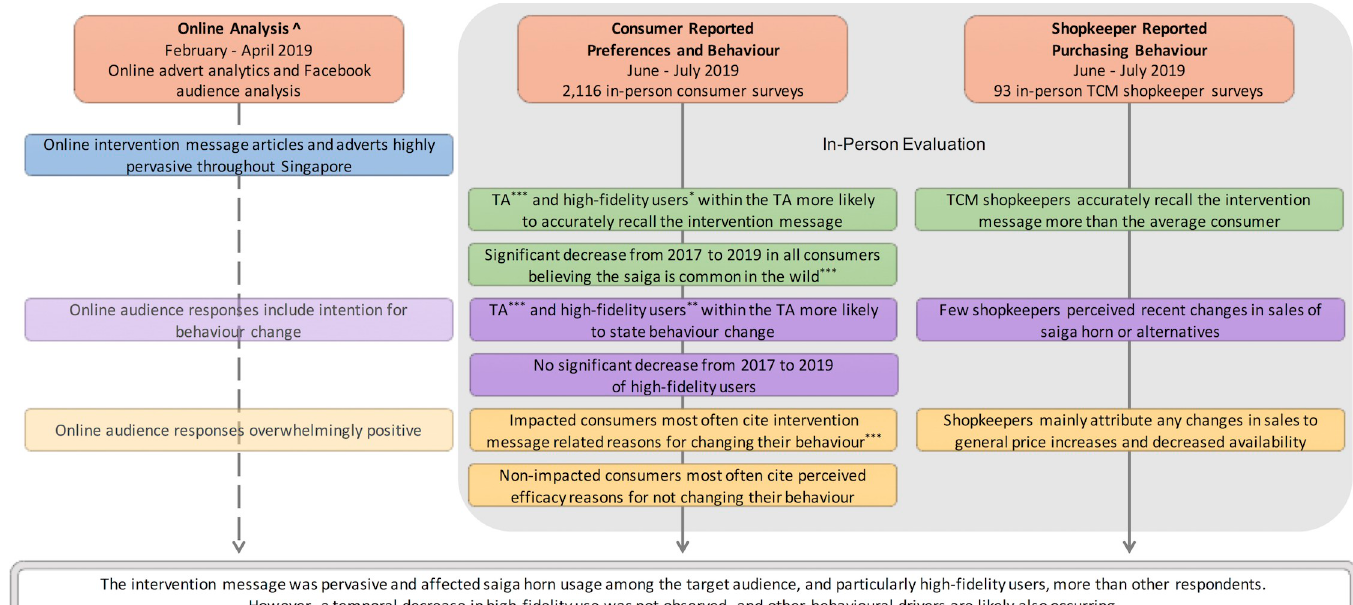
Fig 2. Evaluation summary, including key results from multiple datasets that most elucidated intervention effects. Result box colours correspond to the Theory of Change stages outlined in Fig 1. Transparent colouring indicates a result was supporting but not central to assessing a stage. TA = target audience (middle-aged Chinese Singaporean women). Statistical significance denoted with � for p-value < 0.05, �� for p-value < 0.01, and ��� for p-value < 0.001. ^ Online performance findings are presented in [23].